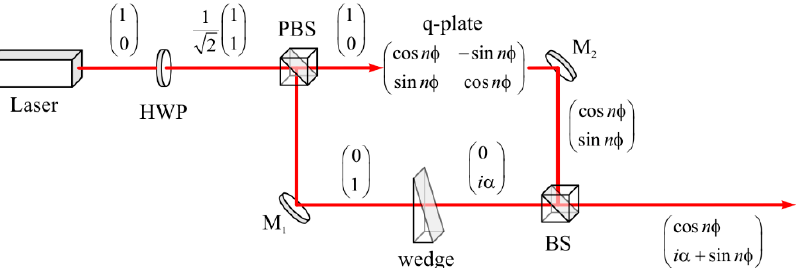
Figure 6. Optical setup for generation of hybridly polarized beam (1). HWP is a half-wave plate; PBS is a polarizing beam splitter; BS is a beam splitter; M 1 , M 2 are mirrors.